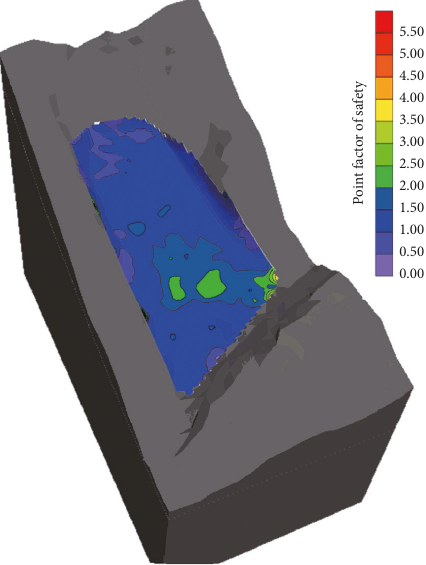
Figure 7: Distribution of factor of safety at the natural state.